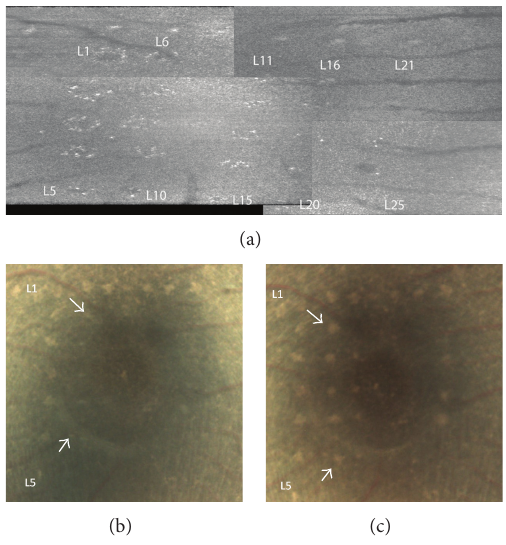
Figure 8: (a) OCT en face images collected 1 hour after exposure of retinal area receiving 413 nm light insult (41–1,089J/cm 2 ). (b) Color fundus image of same retinal area shown in (a) 1 hour after exposure. (c) Color fundus image of same subject 10 days after